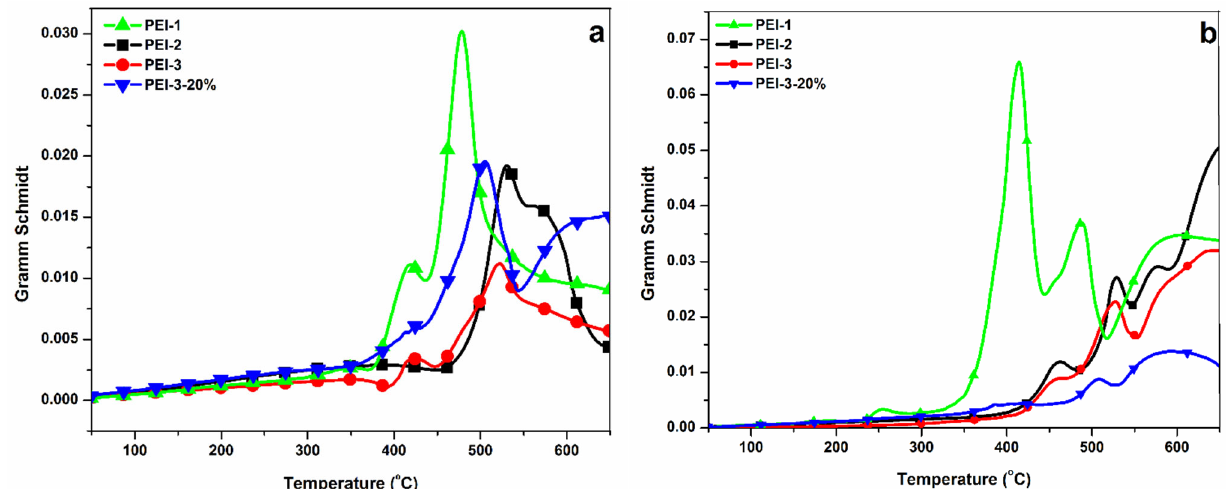
Figure 3. Gram–Schmidt diagram in nitrogen ( a ) and air ( b ) for PEIs (1–3) and PEI ‐ 3 ‐ 20%.